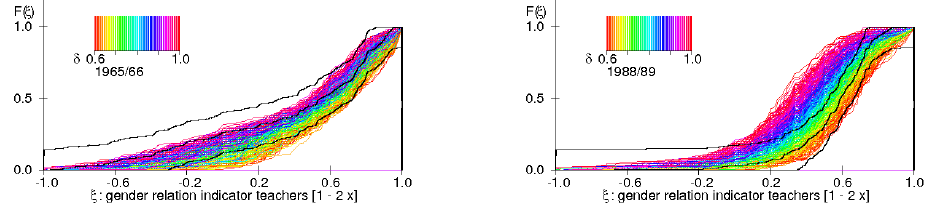
Figure 3. Observed cumulative frequency distribution and its 80 per cent conficence band (black) and simulated cumulative frequency distributions for varying δ (colour) between 0.6 and 1.0 and κ between 0.0 and 1.0 (the effect of the latter is not shown ). Left: 1965/66, right: 1988/89.